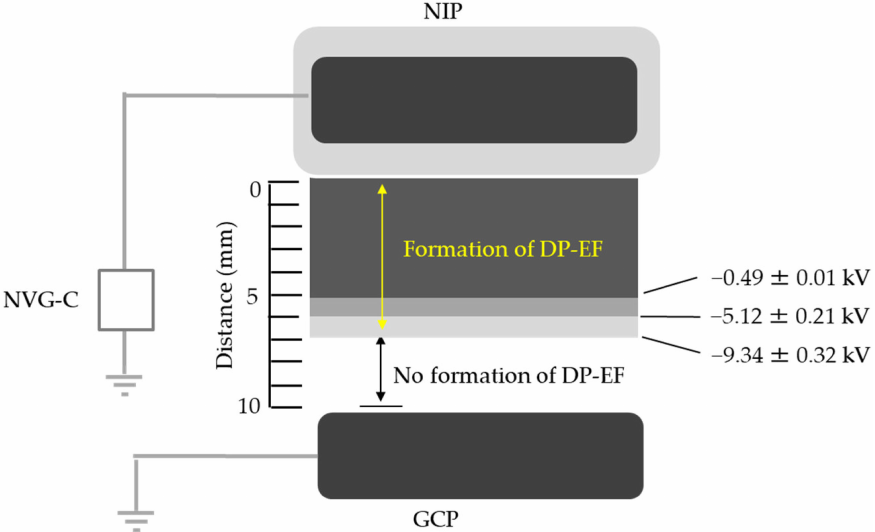
Figure 6. The voltages required to form a dipolar electric field (DP-EF) between a negatively charged insulated conductor (iron) plate (NIP) and a grounded conductor plate (GCP), which were spaced by different distances (5–10 mm). The NIP was linked to a negative voltage generator (continuous-charge type) (NVG-C) and charged with different voltages (–0.1 to –10